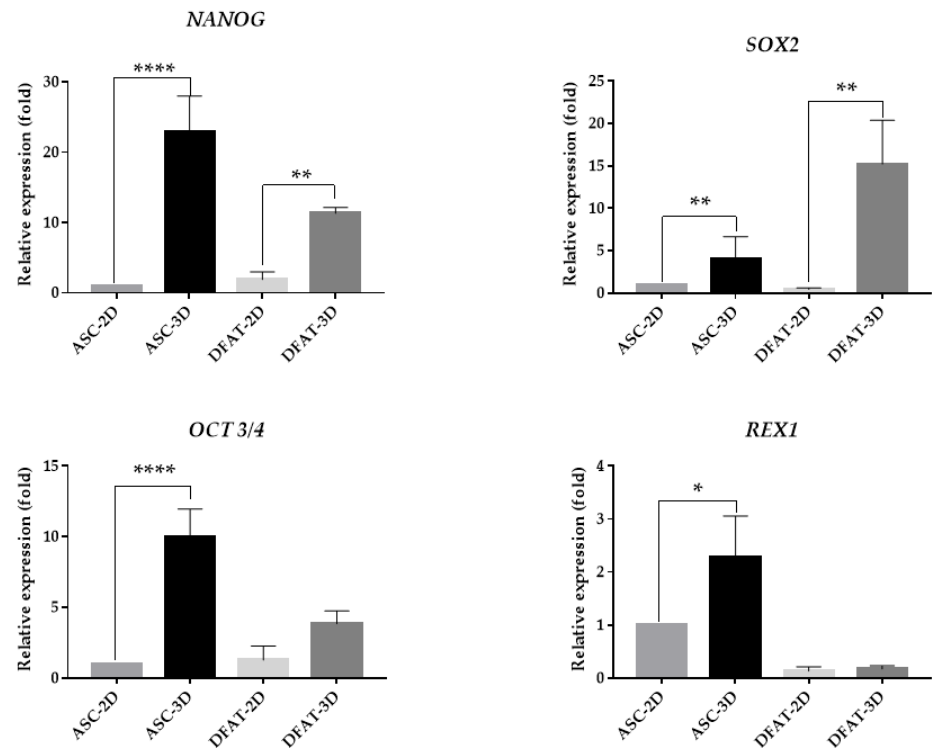
Figure 6. Relative expression fold values of pluripotency genes: NANOG, SOX2, OCT 3/4, and REX1 with β -ACT as a reference gene and ASCs-2D as the control group. The results are presented as mean values of 5 experiments ± SD, for * p < 0.05, ** p <0.01, **** p < 0.0001.